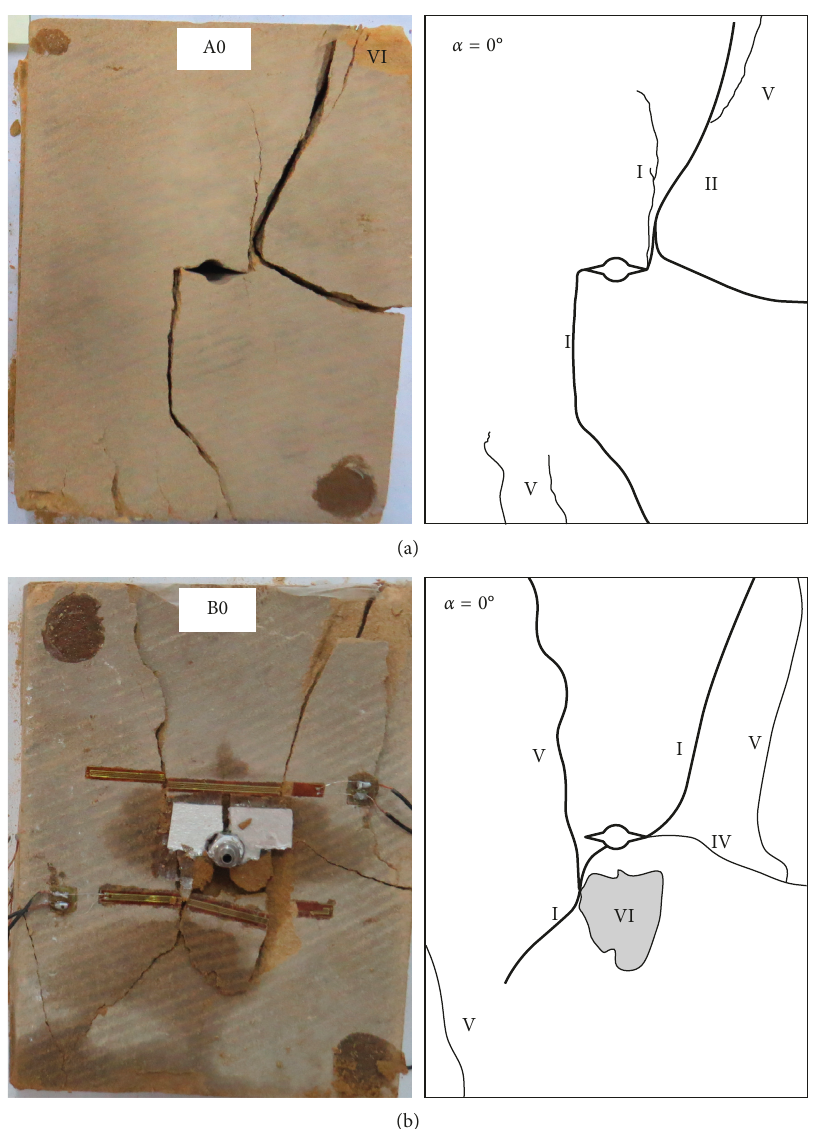
Figure 6: Effect of seepage pressure on ultimate failure modes of sandstone specimens containing fissure angle α pressure. (b) With seepage